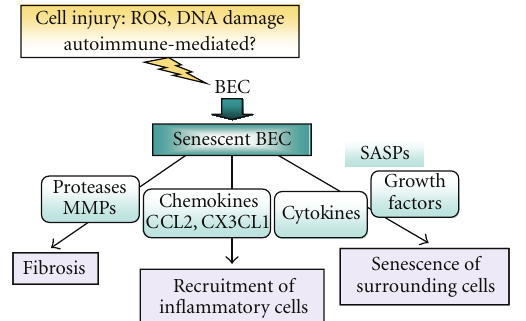
Figure 5: Possible regulation of microenvironment by senescent BECs expressing SASPs in PBC. Senescent BECs may function in modulation of the inflammatory microenvironment by recruiting monocytes and possibly other inflammatory cells by secreting chemokines and cytokines as SASPs. Senescent BECs may also participate in the induction of senescence in surrounding cells and progression of fibrosis via